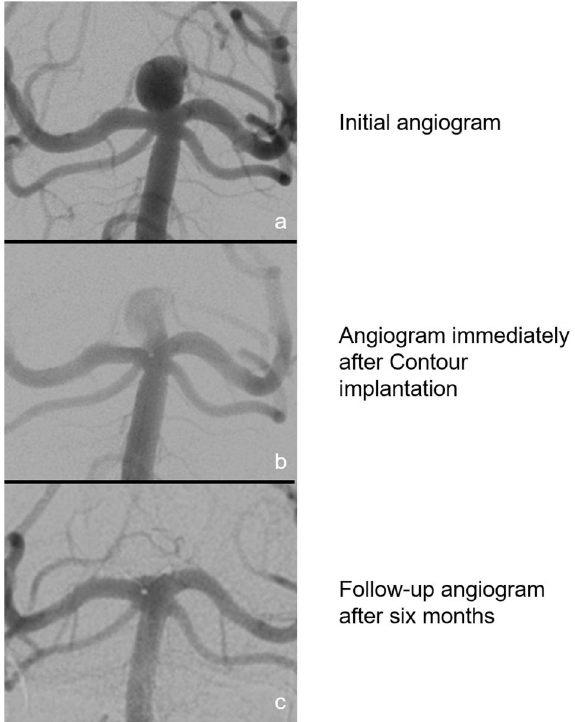
Figure 2. Initial, postinterventional and follow-up angiograms of a patient after Contour implantation into an aneurysm basilar apex with a dome-to-neck ratio of 2.3. The patient presented with a basilar tip aneurysm